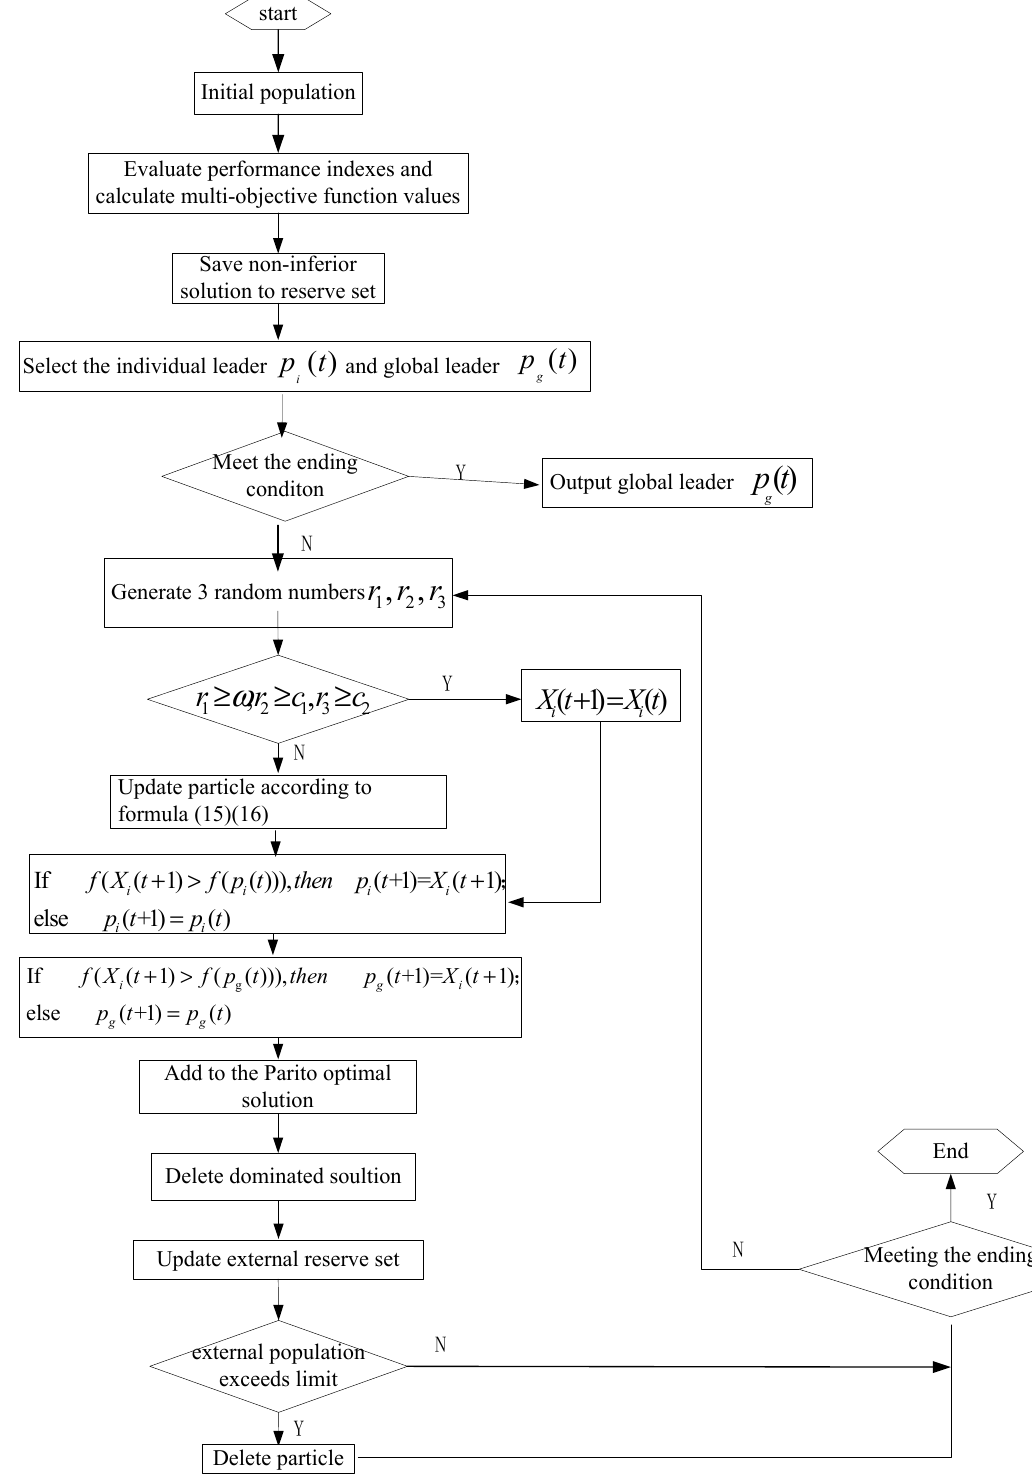
Figure 3. Chart of the multi-objective discrete particle swarm optimization (MODPSO) algorithm.